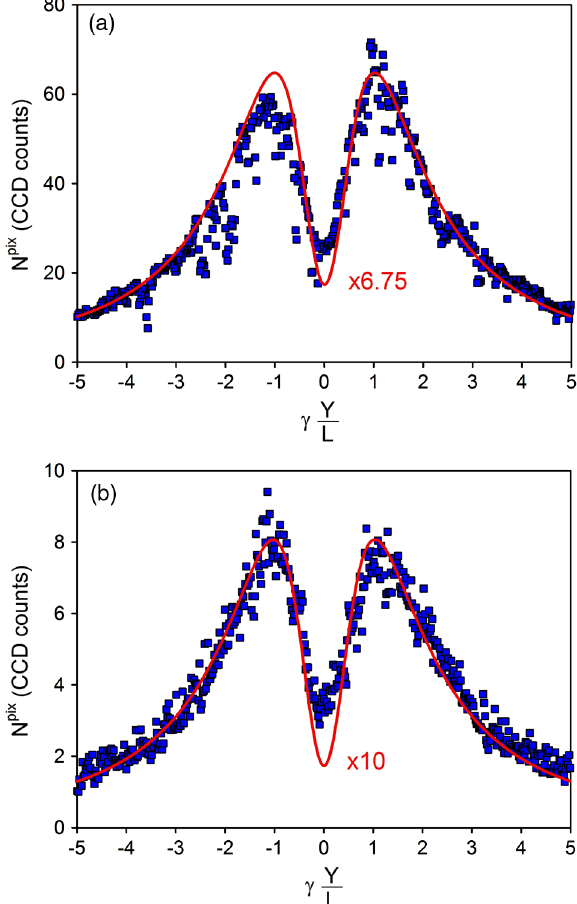
FIG. 5. Vertical cuts of calculated (red solid line) and measured (blue squares) BTR spatial distributions at γ X=L ¼ 0 for beam No. 1, Al foil filter 1 . 3 μ m, and α ¼ 28 . 1 ° (a), α ¼ 67 . 5 ° (b). To aid the comparison, the theoretical curves are scaled by intensity. The scaling factor is 6.75 for α ¼ 28 . 1 ° and 10 for α ¼ 67 . 5 °.